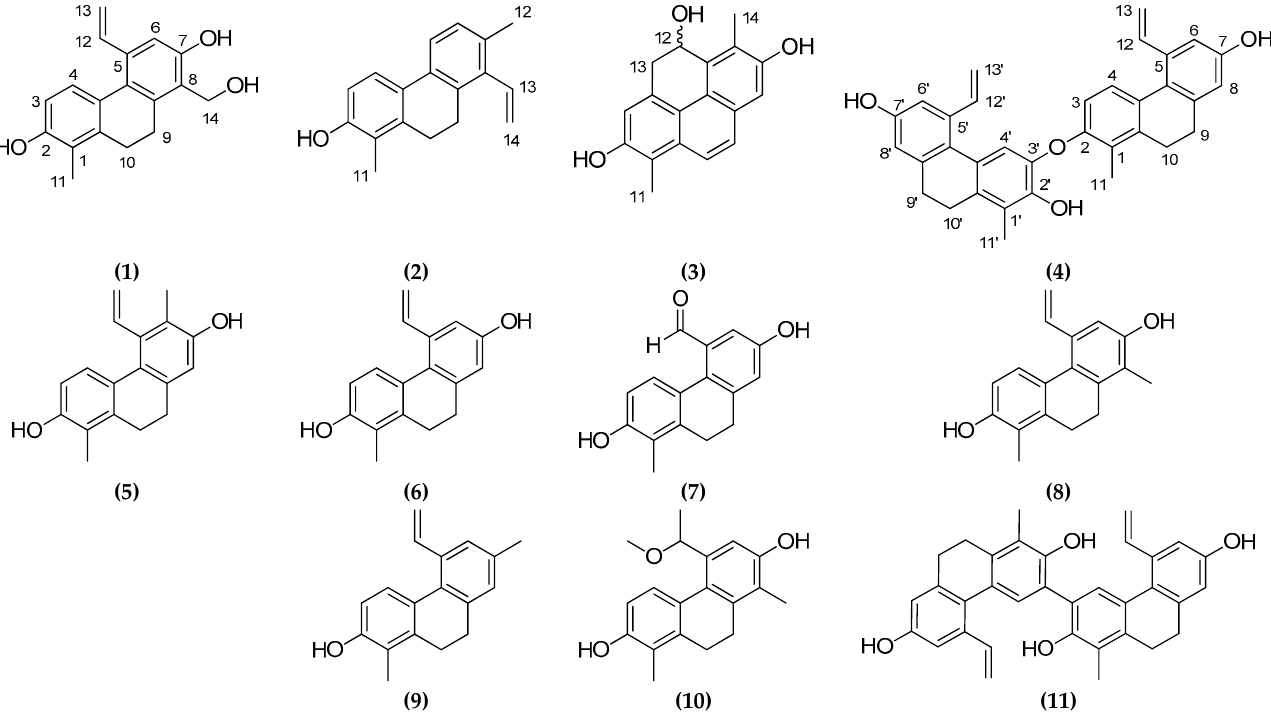
Figure 1. Structures of phenanthrenes ( 1 – 11 ) isolated from Juncus maritimus .